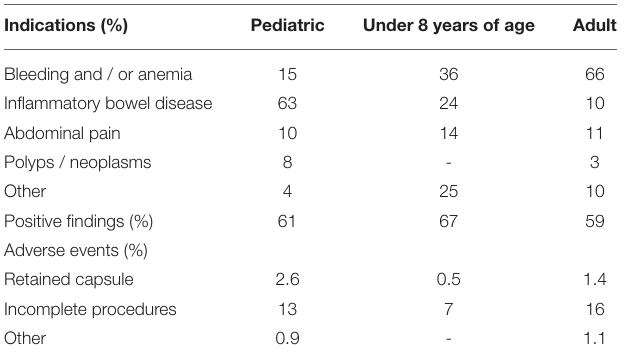
TABLE 1 | Indications, outcomes, and adverse events in capsule endoscopy procedures on pediatric and adult patients (8). Indications (%)